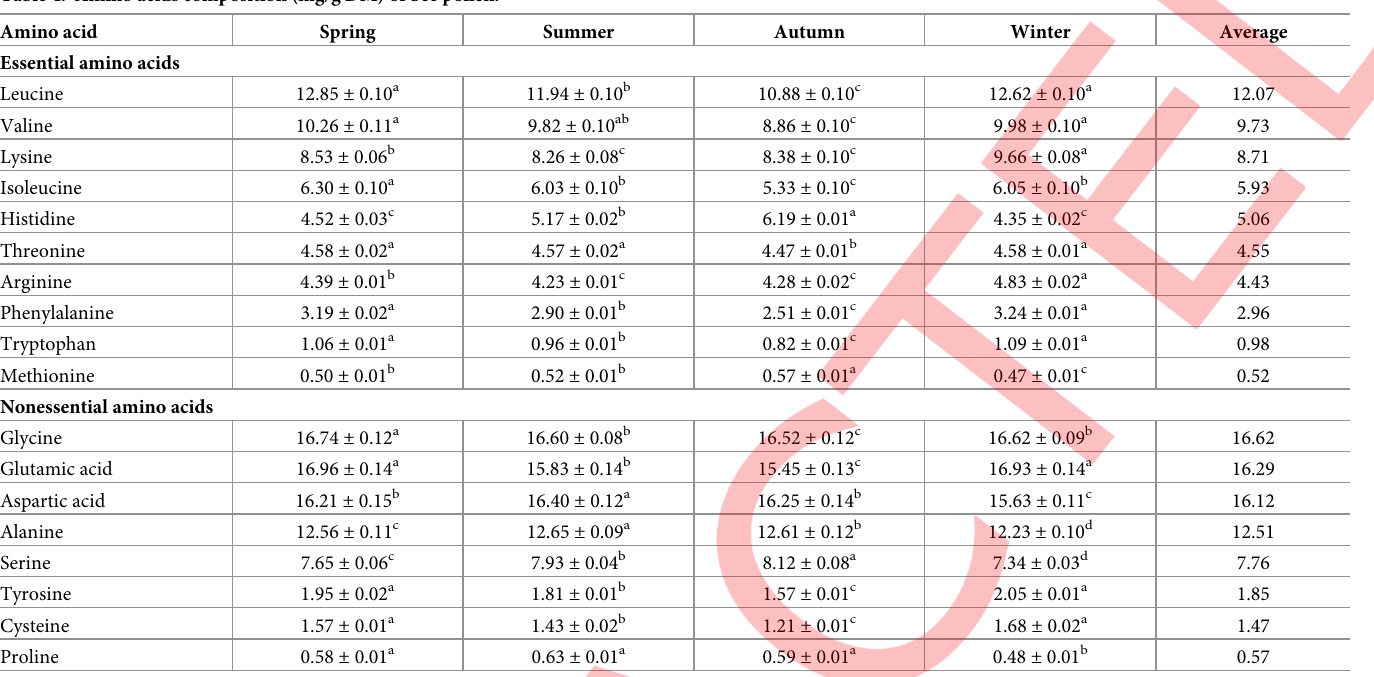
Values are the mean ± standard deviation. Means of each row followed by a different letter are significantly different at the 0.01